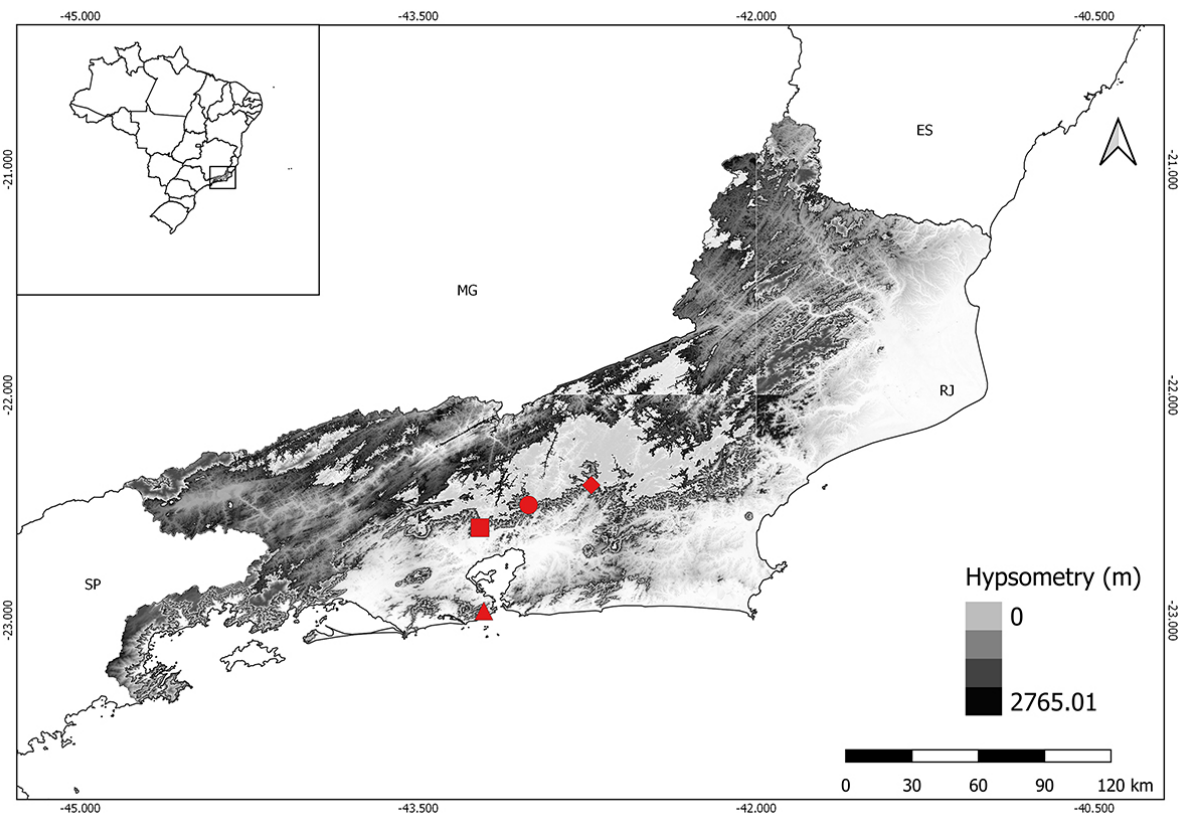
Figure 1 – Localities of the specimens assigned as C. gaudichaudii and C. aeneus analyzed in the present work. ▲ Crossodactylus gaudichaudii from Parque Lage, Rio de Janeiro city (probable type locality of this species – see text for detail); ■ Crossodactylus aeneus from the Taquara Municipal Natural Park (PNMT), municipality of Duque de Caxias; ● Crossodactylus aeneus (topotype) from Barreira, municipality of Guapimirim; and